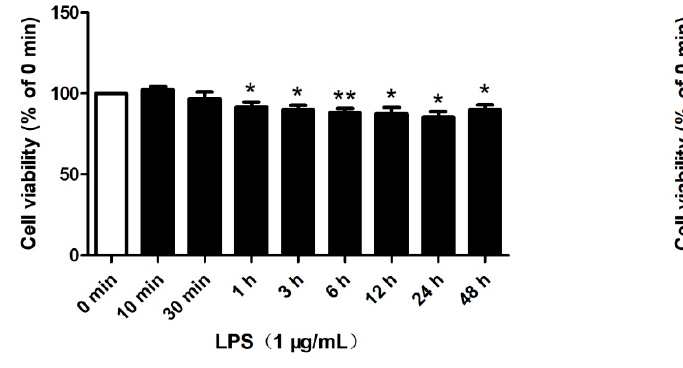
Figure 1. Effects of LPS and PA on the viabilities of HepG2 cells. Cells were treated with 1 µ g/mL LPS ( A ) or 200 μ mol/L PA ( B ) for different times (0 min, 10 min, 30 min, 1 h, 3 h, 6 h, 12 h, 24 h, and 48 h). MTT assays were performed to determine the cell viability. The results are presented as means ± SD in triplicate ( n = 6); *: p < 0.05 vs. 0 min; **: p < 0.01 vs. 0 min.